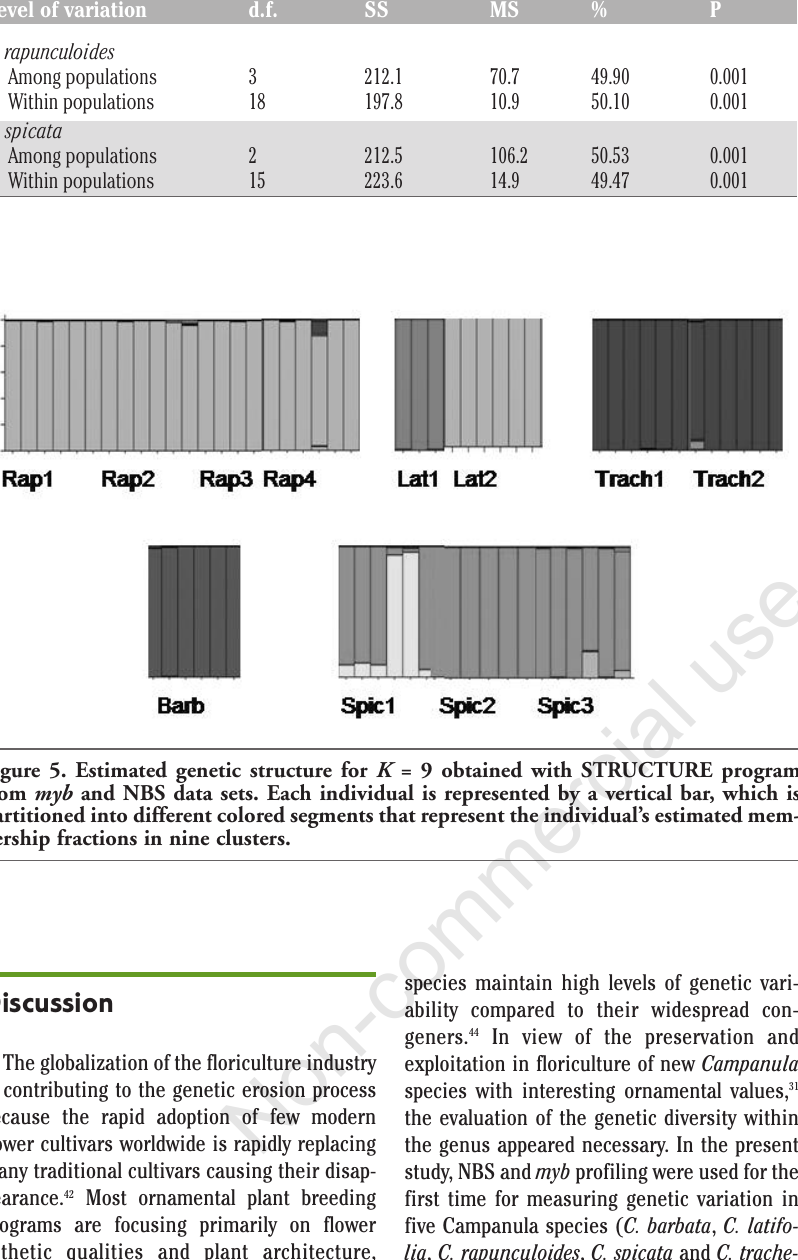
Table 5. Analysis of molecular variance performed on the populations of C. rapuncu- loides and C. spicata . Level of variation